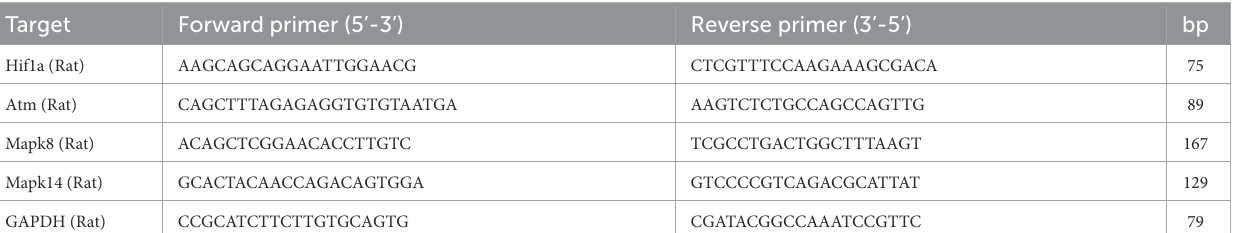
TABLE 1 The primers for